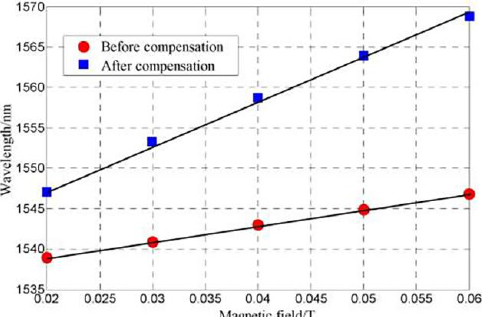
Figure 14. Comparison of the magnetic field sensitivity before and after thermal effect compensation. Reproduced from [52].